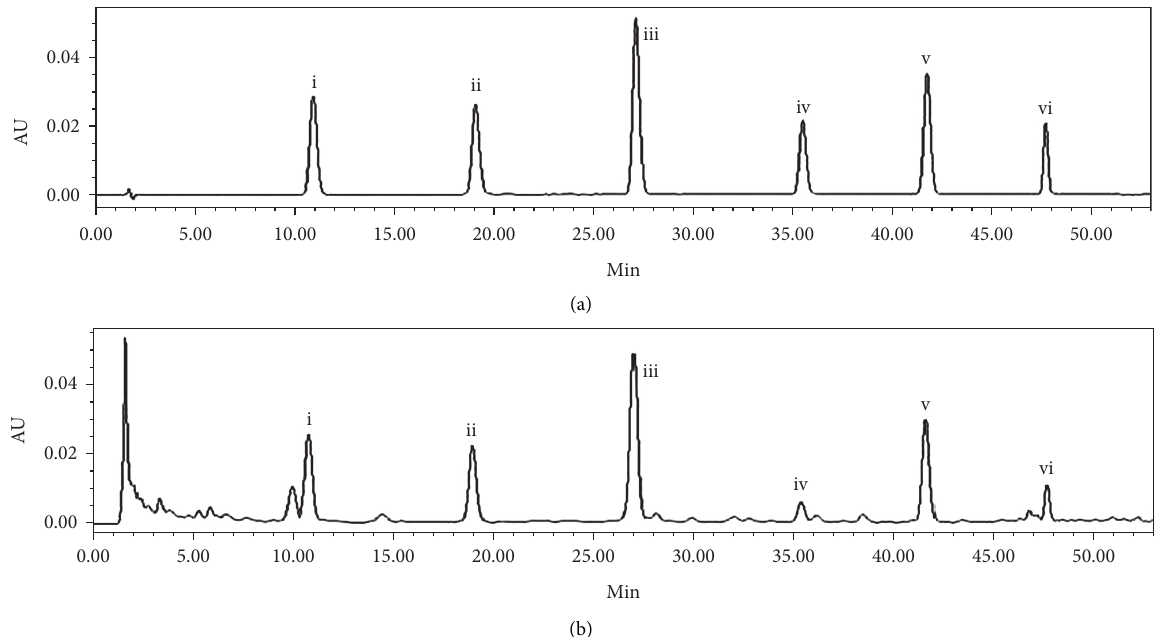
Figure 2: The chromatograms of the mixed reference standard solution (a) and test solution (b). The peaks represent (i) prim-(O)- glucosylcimifugin, (ii) cimifugin, (iii) 4 ′ -(O)- β -D-glucosyl-5-(O)-methylvisammino, (iv) 5-(O)-methylvisamminol, (v) sec-(O)-gluco- sylhamaudol, and (vi) hamaudol. Table 1: Regression equations, correlation coefficients, linearity ranges, limits of detection, and limits of quantification for six indicators. Indicator